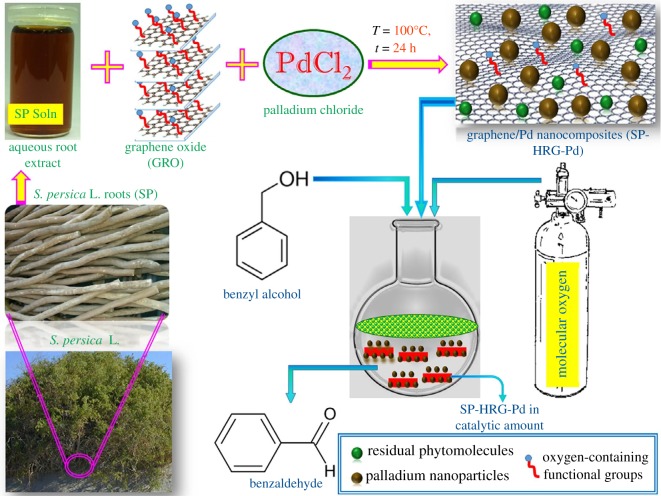
Schematic illustration of the green synthesis of Pd@graphene (SP-HRG-Pd) nanocomposites using Salvadora persica L. root extract (RE) as bioreductant. The as-prepared nanocomposite is also applied as oxidation catalyst for the transformation of various alcohols. Adapted from Elsevier.